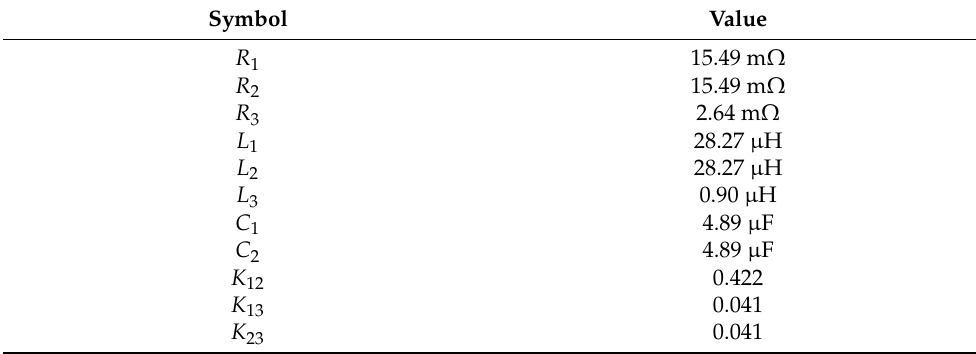
Table 3. V A at different transmission distances.